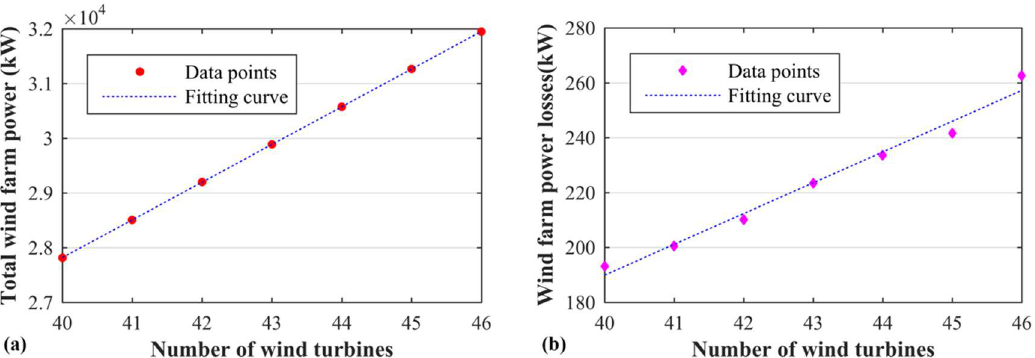
Figure 9. Probability of variable wind speeds and variable wind directions.